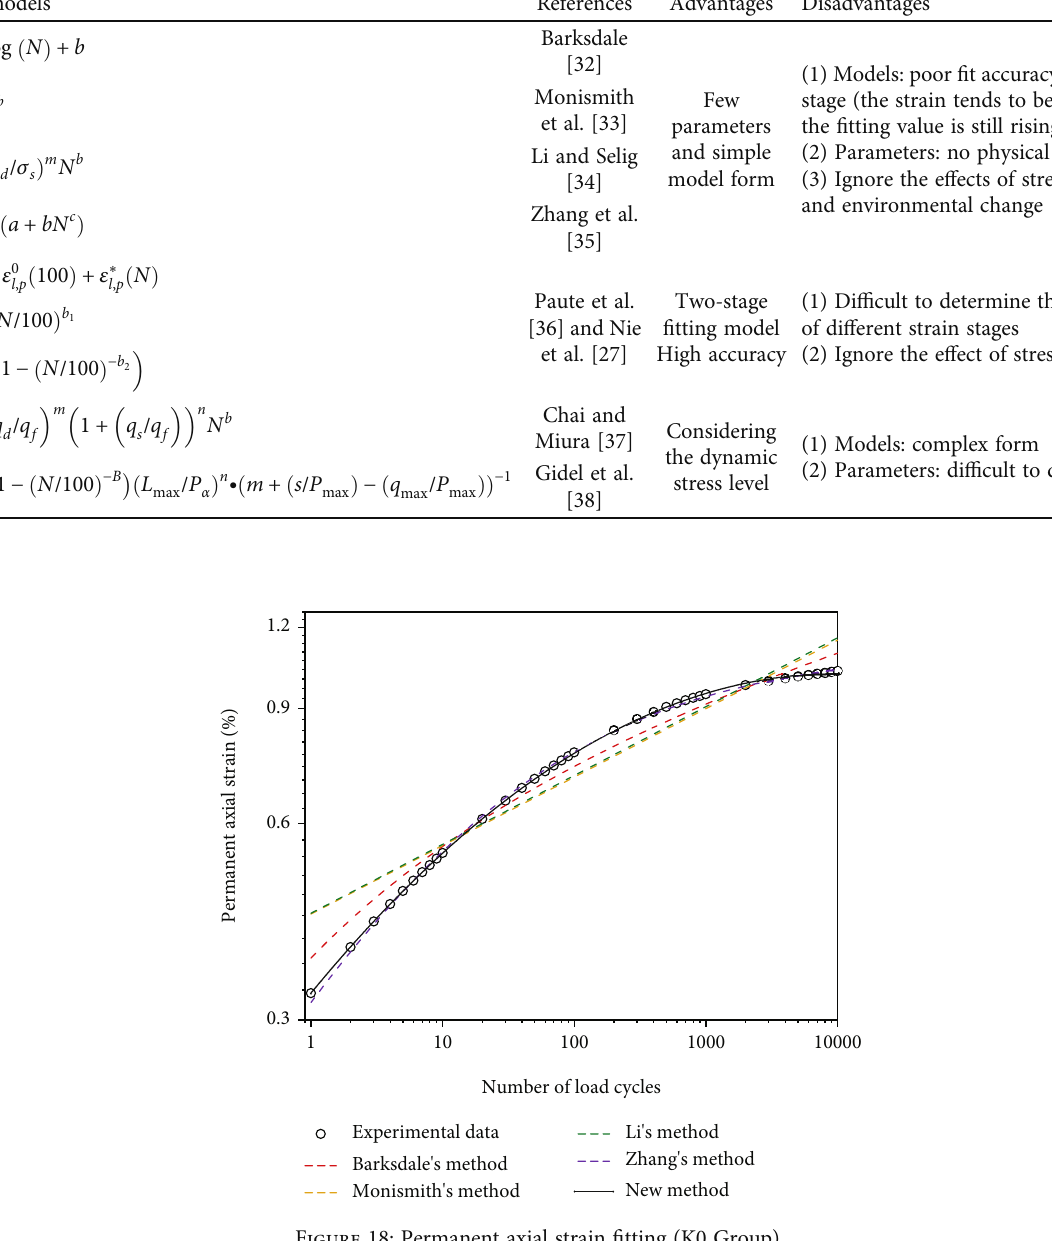
Figure 18: Permanent axial strain fi tting (K0